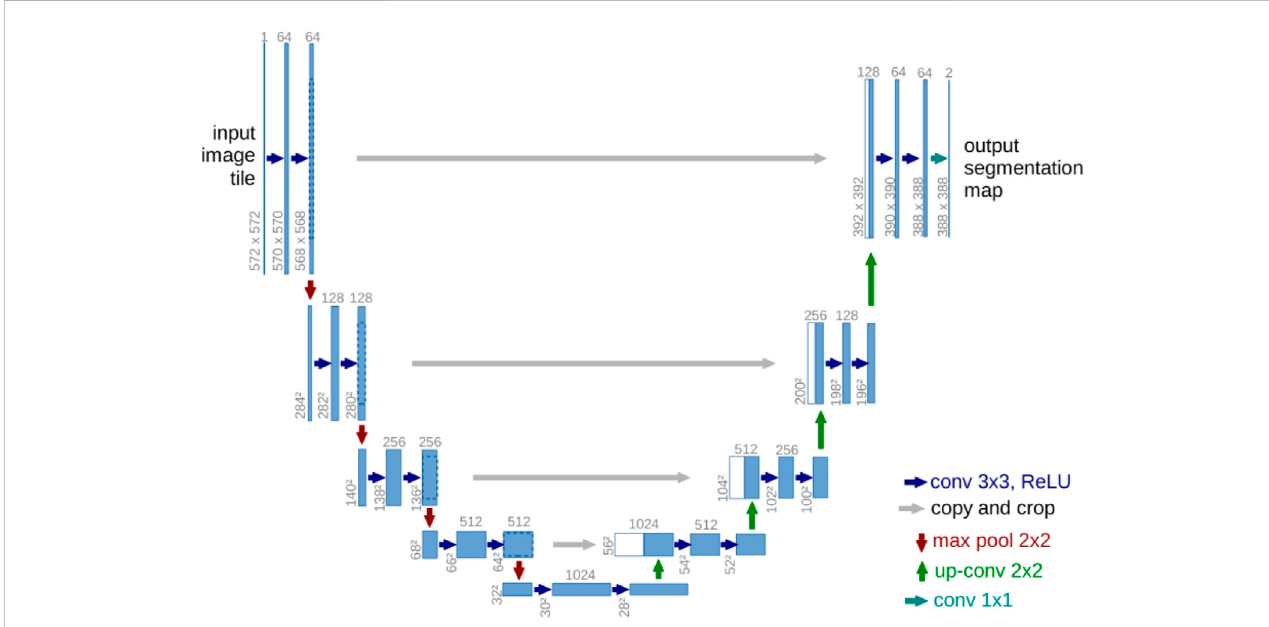
FIGURE 3 U-Net architecture using long skip connections (Ronneberger et al.,